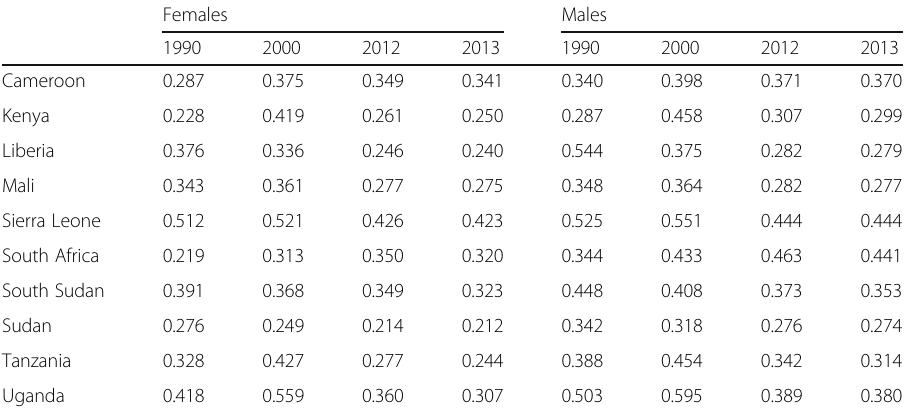
Table 7 World Health Organization adult mortality estimates ( 45 q 15 ) by country and sex